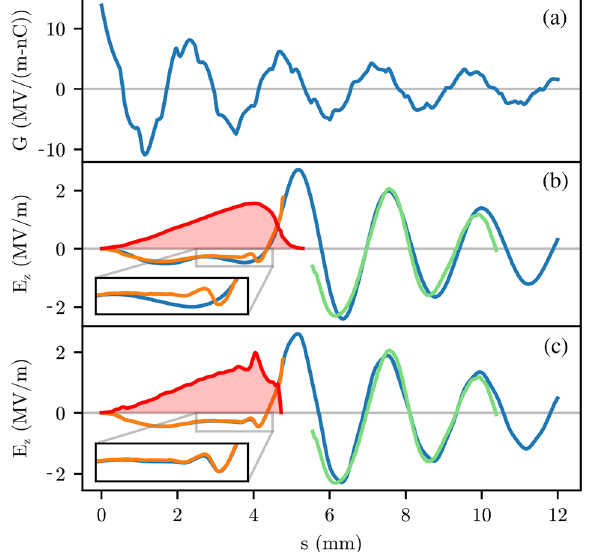
FIG. 5. (a) Green ’ s function for the structure that was used in Ref. [20] for measuring the wake field. (b) Charge density as measured via LPS diagnostics (red, filled), measured wake field inside the driver (orange), measured wake field behind the driver (green) and theoretical calculation of the full wake field based on a Green ’ s function and charge density measure via LPS diag- nostics (blue) (c) Reconstructed charge density (red, filled), measured wake field inside the driver (orange), measured wake field behind the driver (green) and theoretical calculation of the full wake field based on a Green ’ s function and reconstructed charge density